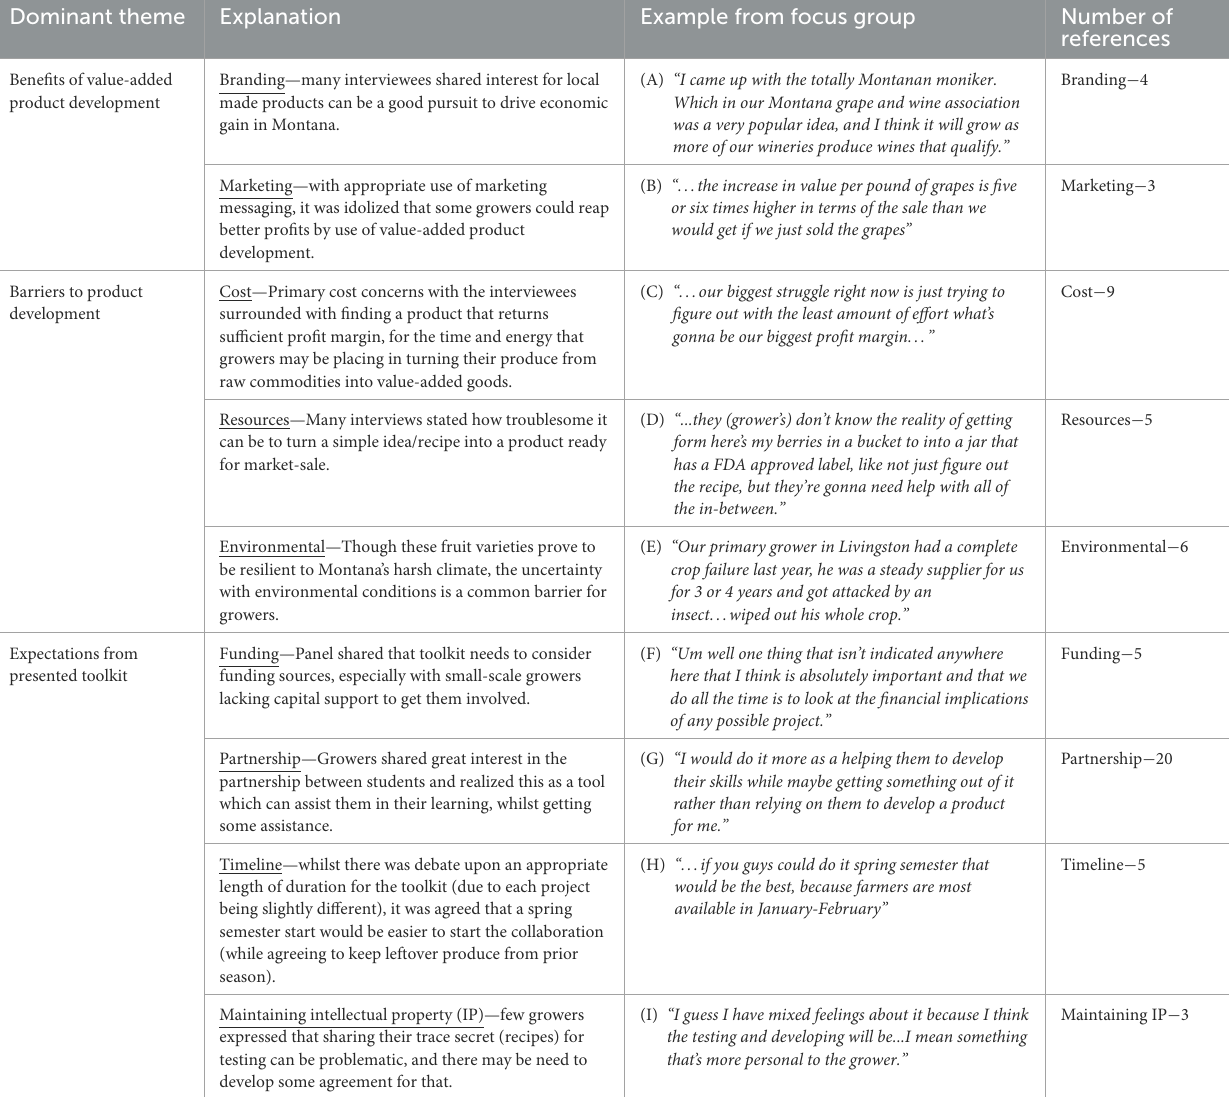
TABLE 3 Dominant themes from the individual interviews with specialty fruit growers in